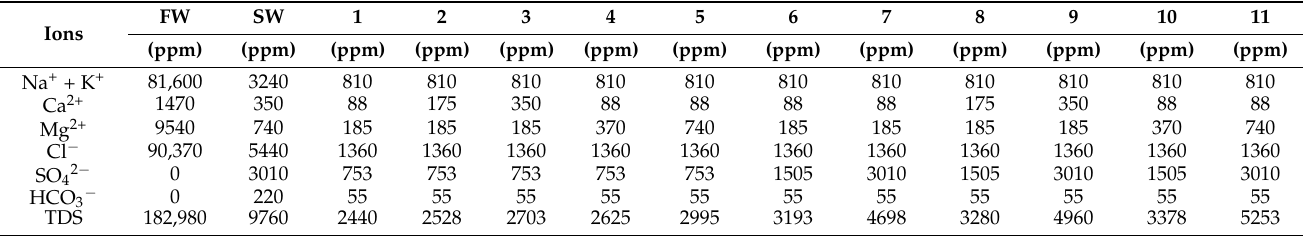
Table 3. Composition of